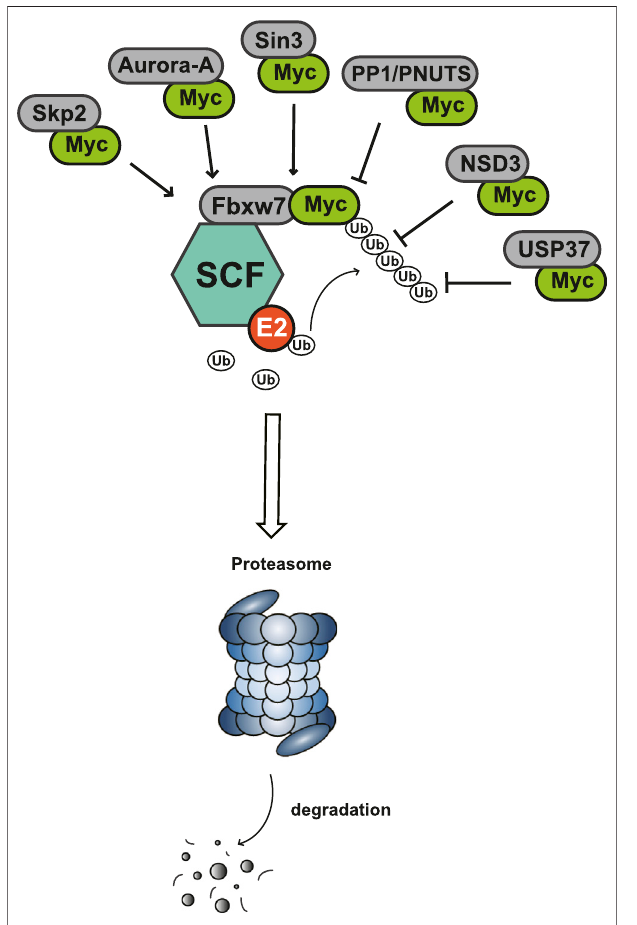
FIGURE 3 | Protein-protein interaction works on Myc